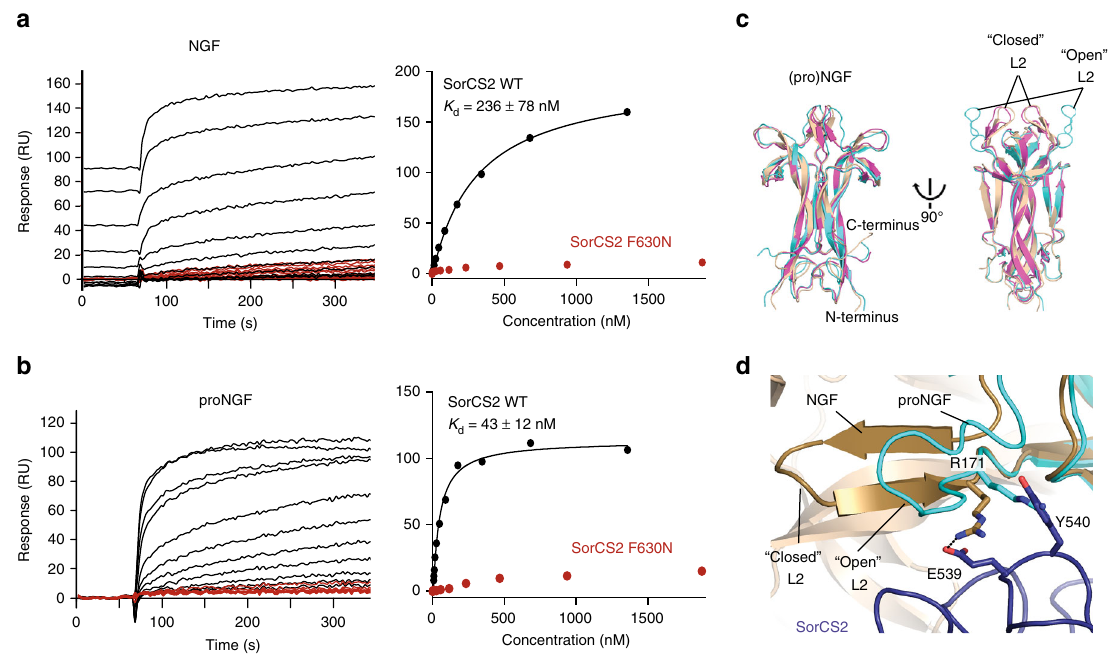
Fig. 4 Both pro- and mature NGF directly bind SorCS2 on top of the β -propeller. a , b NGF ( a ) and proNGF ( b ) bind directly to sSorCS2 and interaction is abrogated by the F630N interface mutation on sSorCS2. Surface Plasmon Resonance sensorgrams of the association phase (left) and equilibrium binding plot (right) of sSorCS2 (black) and sSorCS2 F630N (red) binding to NGF and proNGF. Incomplete regeneration for NGF was accounted for by treating the data as an equilibrium titration experiment 62 . c SorCS2-bound NGF adopts the same conformation as in the 1:2 p75NTR – NGF complex 22 . Superposition of NGF from SorCS2 – NGF (beige), the mature domain of proNGF from the symmetric p75NTR-proNGF structure (pdb-id 3IJ2 12 , cyan) and NGF from the asymmetric p75NTR – NGF structure (pdb-id 1SG1 22 , pink) in cartoon representation. In the SorCS2-NGF structure, NGF adopts a “ closed ” conformation 12 of the L2 loop, comparable to that in the asymmetric p75NTR – NGF structure. d Superposition of proNGF with an “ open ” conformation of the L2 loop